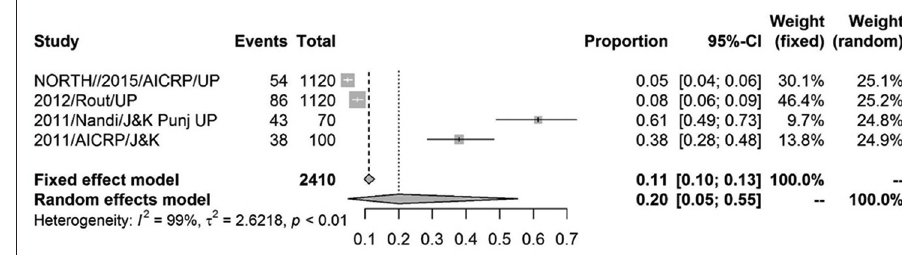
Figure-3: Forest plot of east zone classical swine fever prevalence.